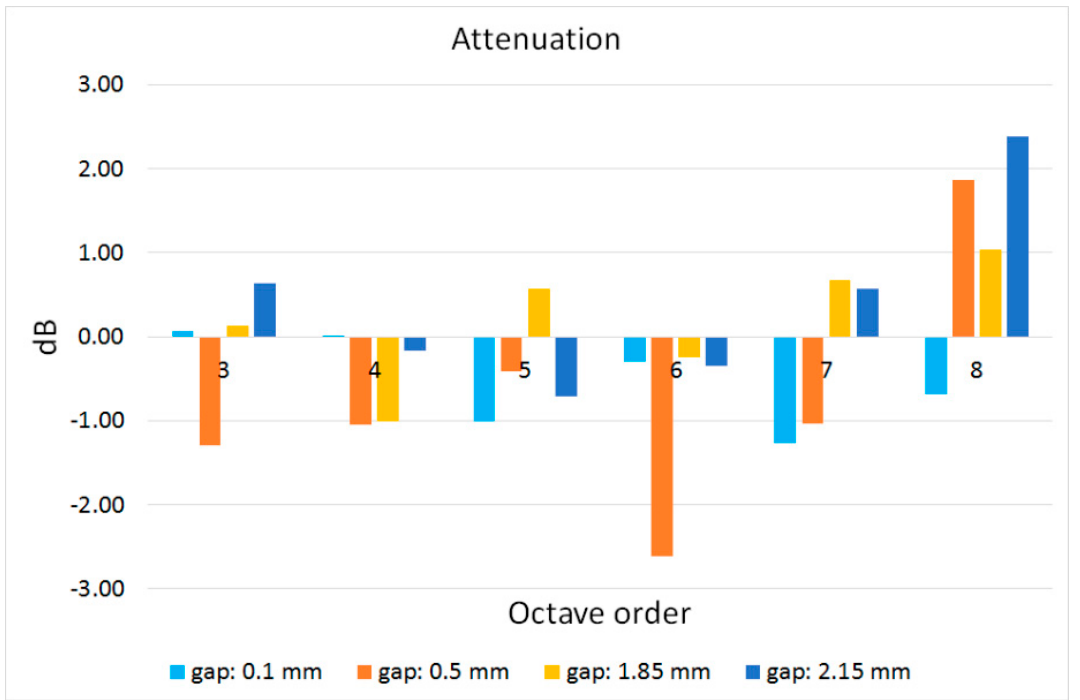
Figure 24. Sound pressure level without activating the SMA system.